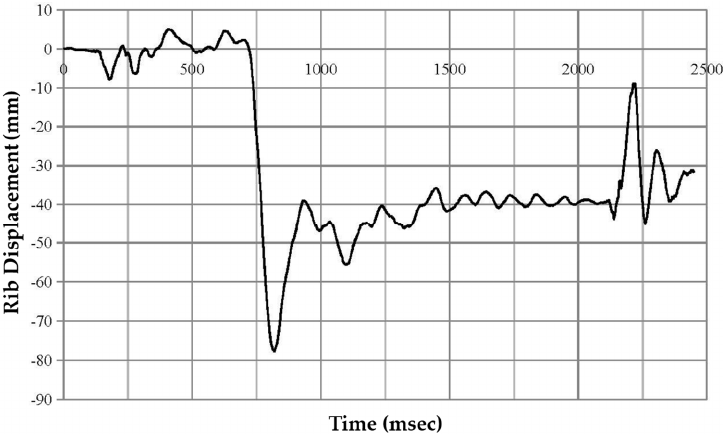
Figure A4. Left A-pillar deformation.